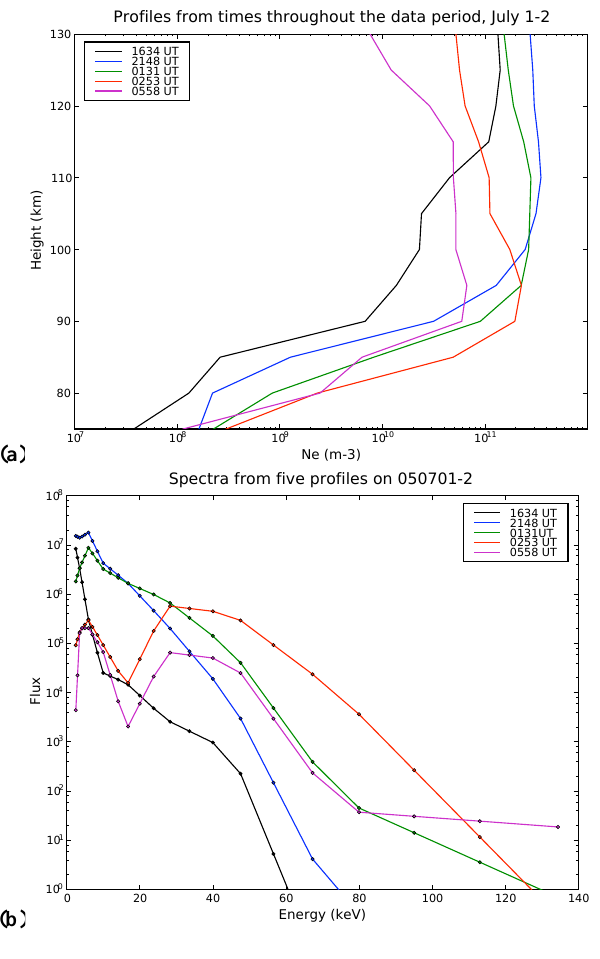
Fig. 3. (a) A selection of electron-density profiles covering the ob- serving period on 1–2 July. The profiles have been corrected for the estimated contribution from solar EUV radiation, which is signifi- cant only in the E region and at the smaller electron-density values.